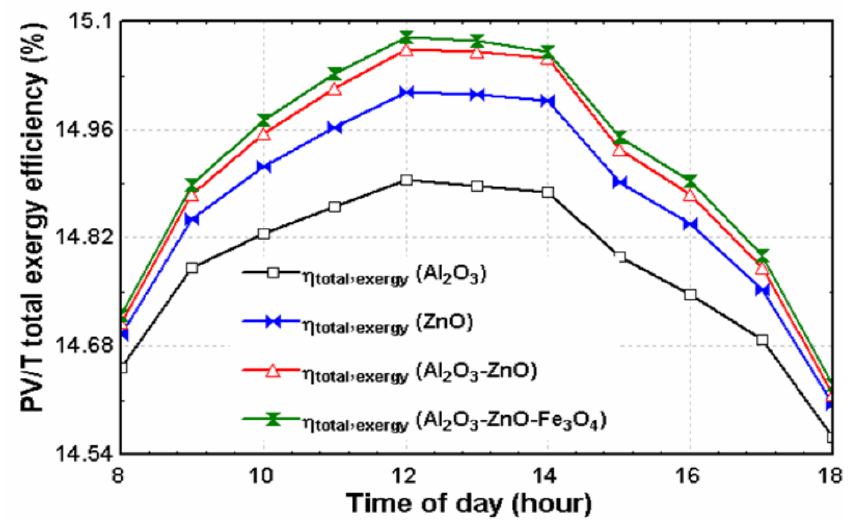
Figure 17. PV/T total exergy